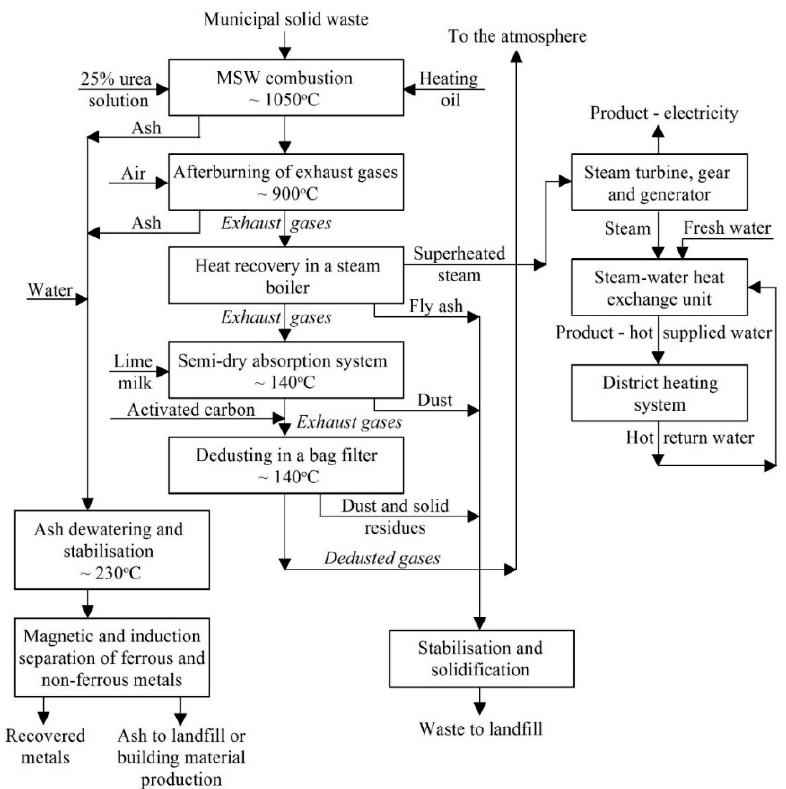
Figure 2. Flowchart of municipal waste combustion at the Cracow Incineration Plant.